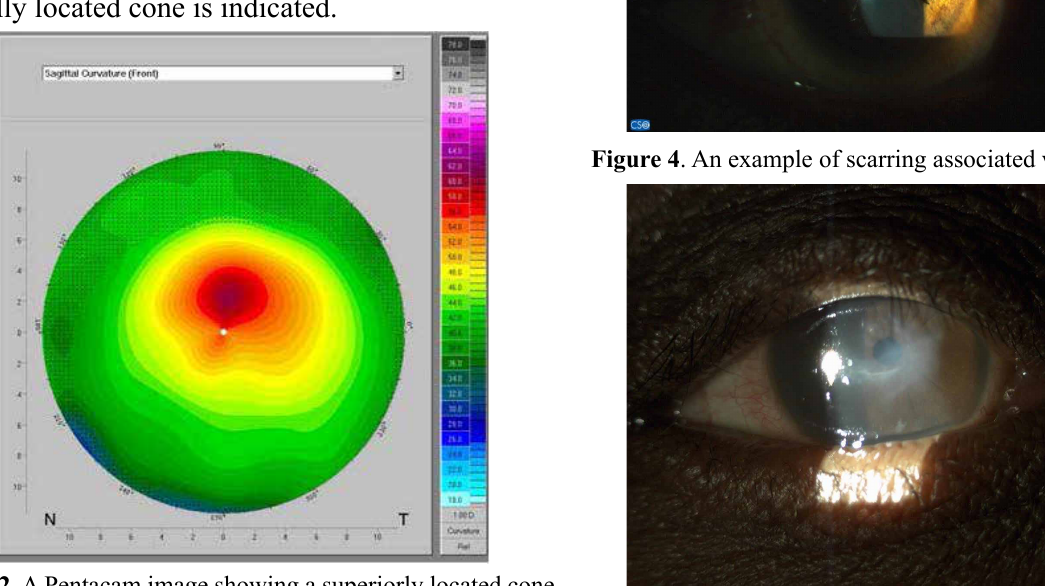
Figure 2 . A Pentacam image showing a superiorly located cone.